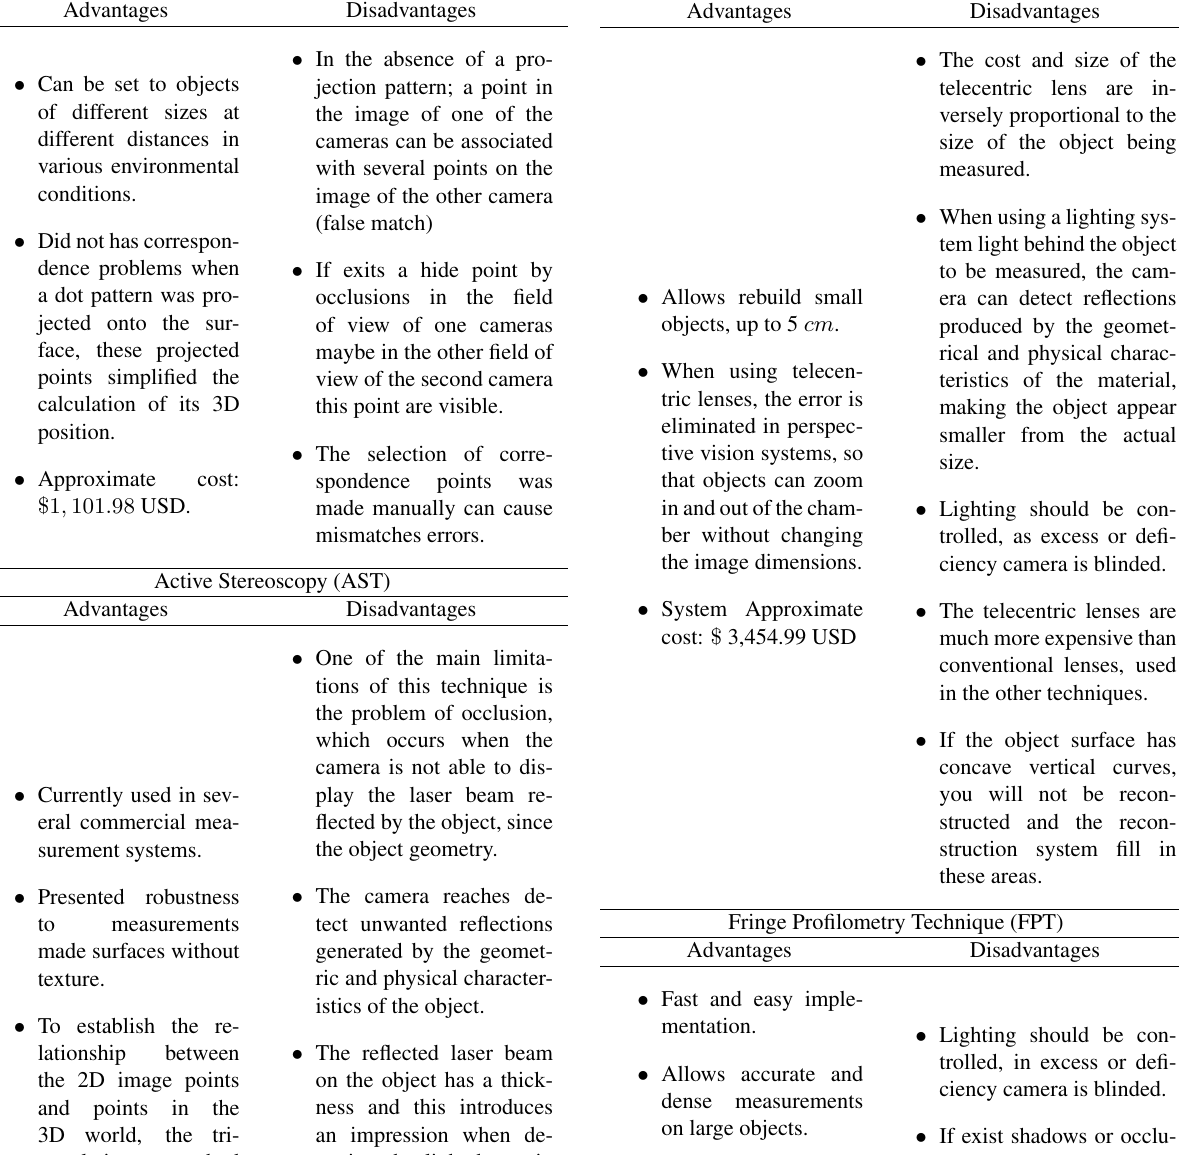
Table 7. Reconstruction techniques SCT and FPT with advantages and disadvantages of our implemented systems.